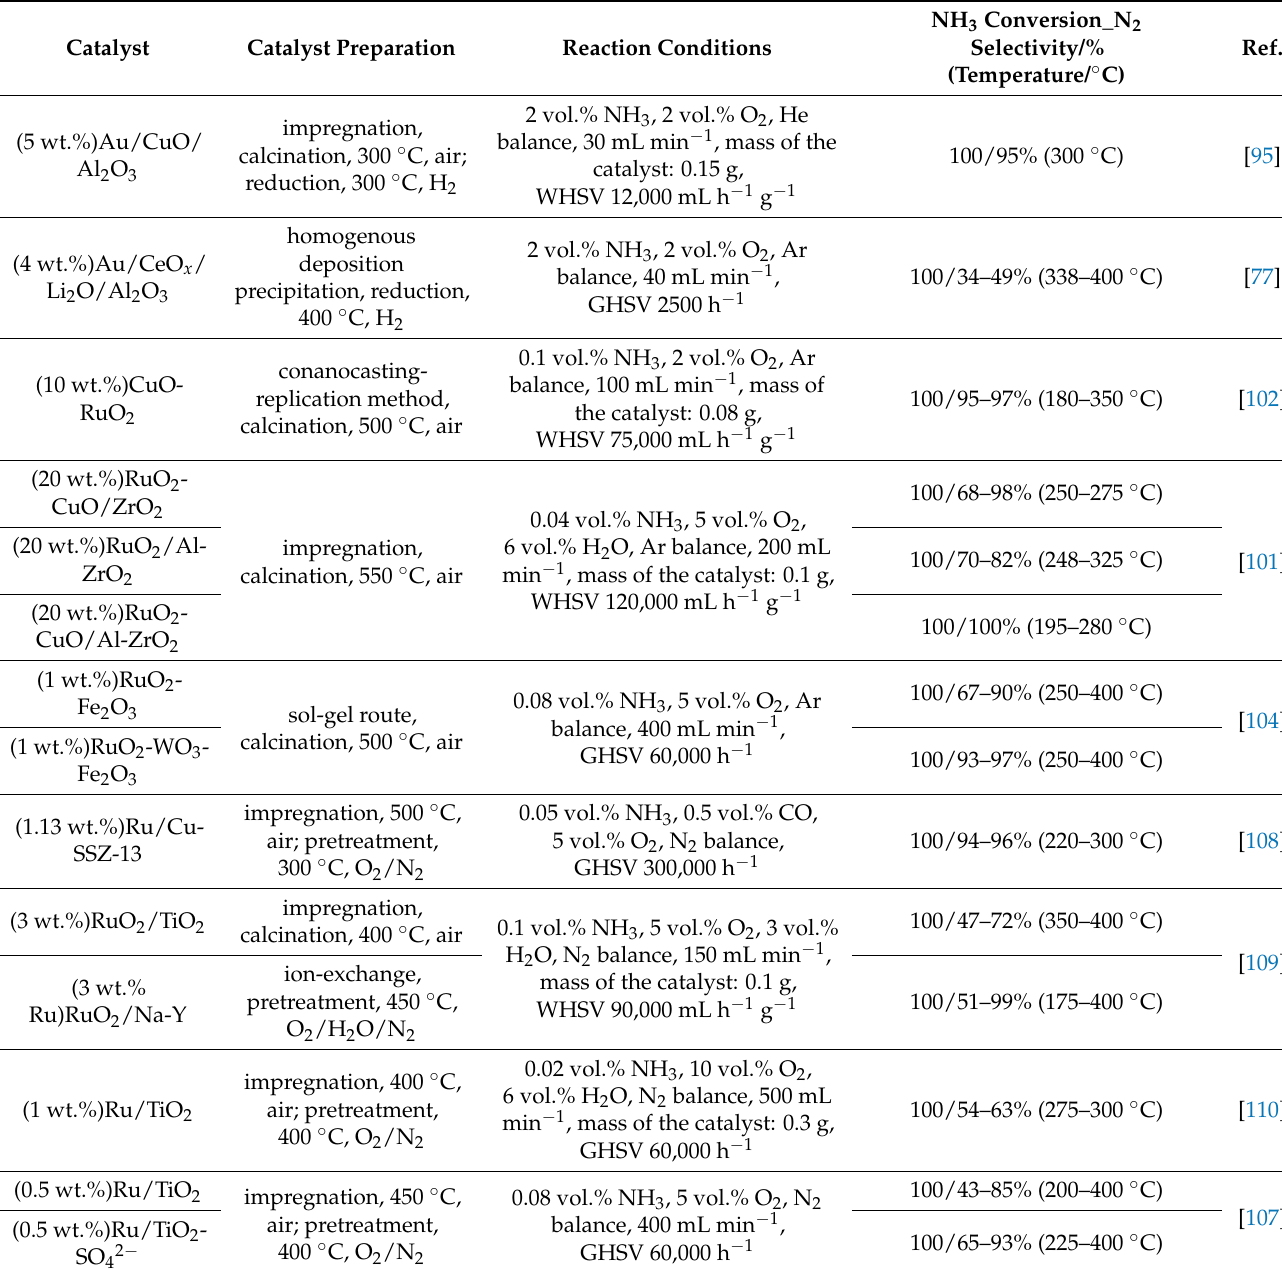
Table 3. Comparison of full NH 3 conversion and N 2 selectivity in same temperature range over Au- and Ru-based catalysts reported in